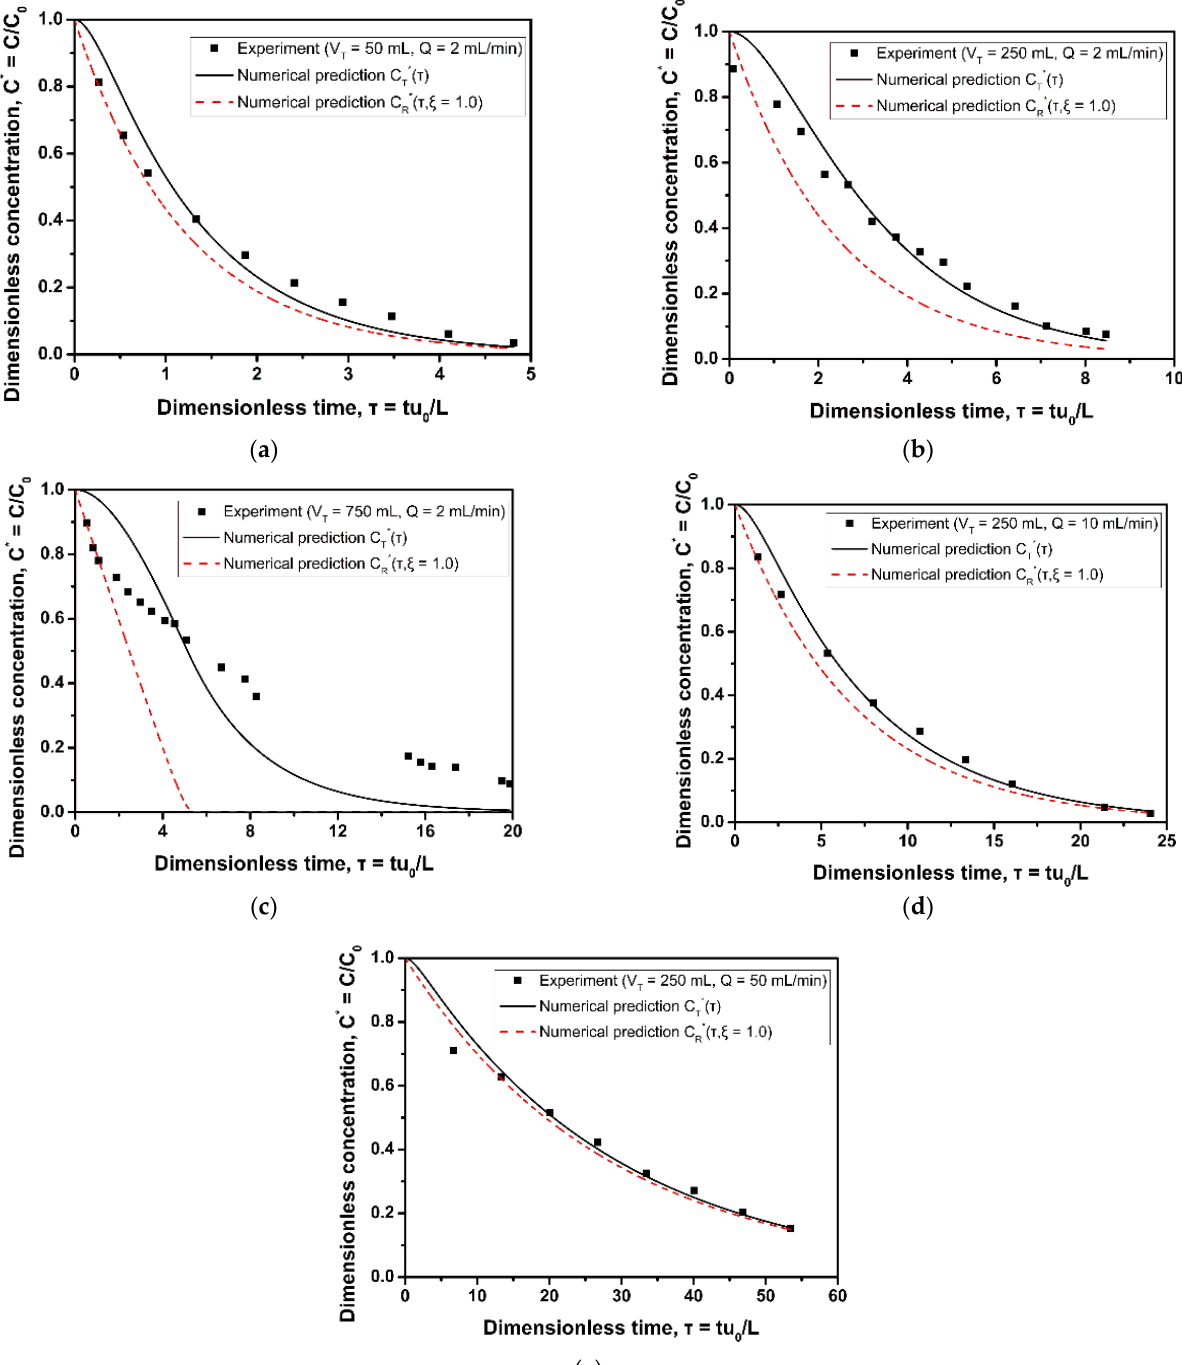
Figure A2. Comparison of numerical prediction with experimental measurements of the transient response of phenol concentration in continuous flow STST photoreactor for various values of the flow rate and liquid volume in recycle tank. ( a ) V T = 50 mL, Q = 2 mL/min; ( b ) V T = 250 mL, Q = 2 mL/min; ( c ) V T = 750 mL, Q = 2 mL/min; ( d ) V T = 250 mL, Q = 10 mL/min; ( e ) V T = 250 mL, Q = 50 mL/min